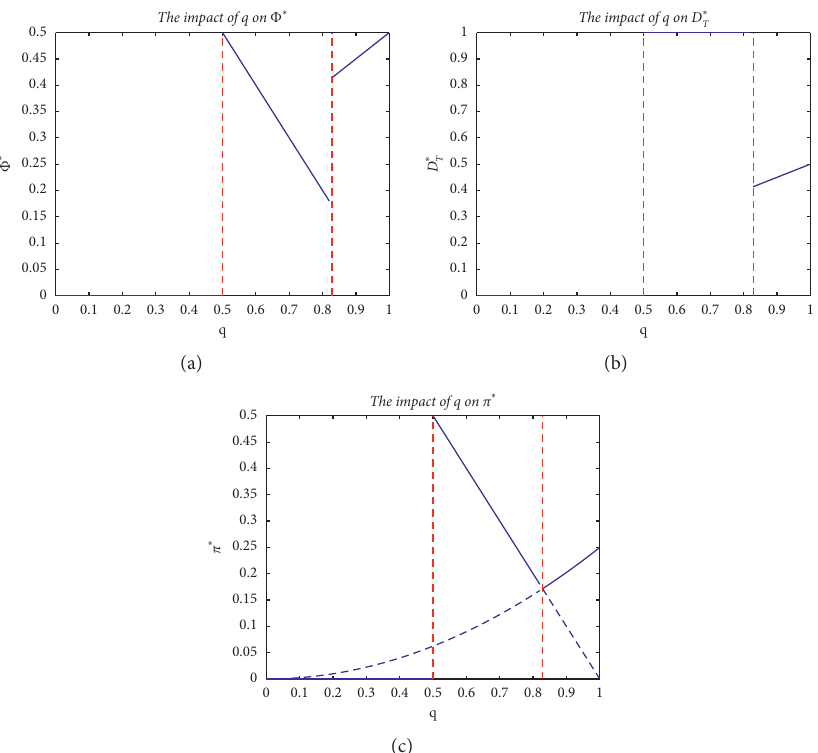
Figure 5: The impact of certification accuracy on (a) the global optimal application fee, (b) the total market demand, and (c) the platform’s optimal